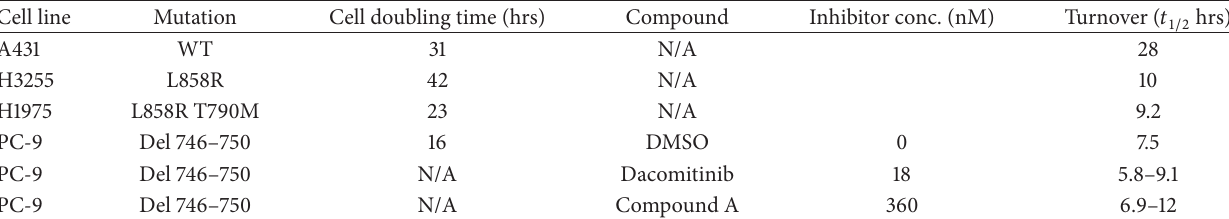
Table 1: Cell lines examined and EGFR turnover rate ( 𝑡 1/2